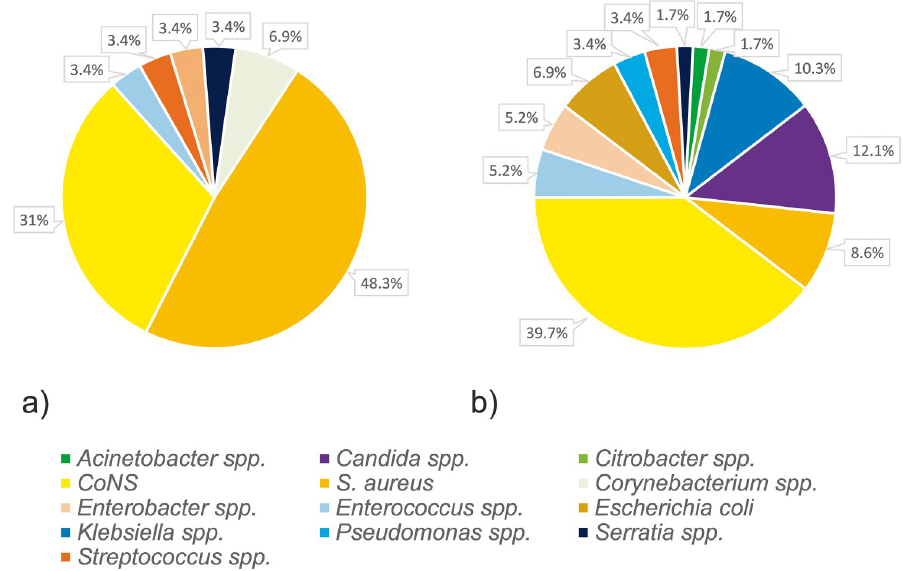
Fig 3. Microbiological spectrum of upper arm port associated infections. Microbiological spectrum of port pocket infections ( a , Group 1) and catheter infections ( b , Group 2). Coagulase-negative staphylococci–CoNS, species–spp.